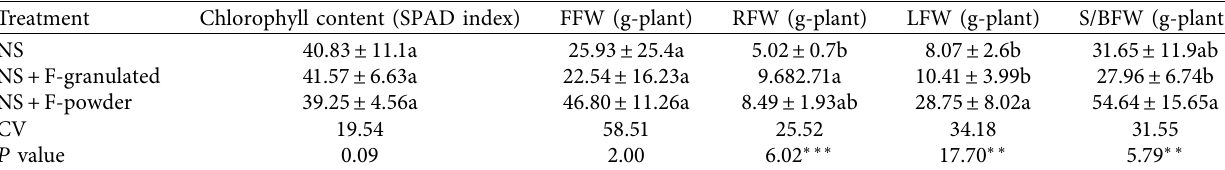
Table 1: Effect of NS and organomineral fertilizer on chlorophyll and fresh weight in cherry tomato.